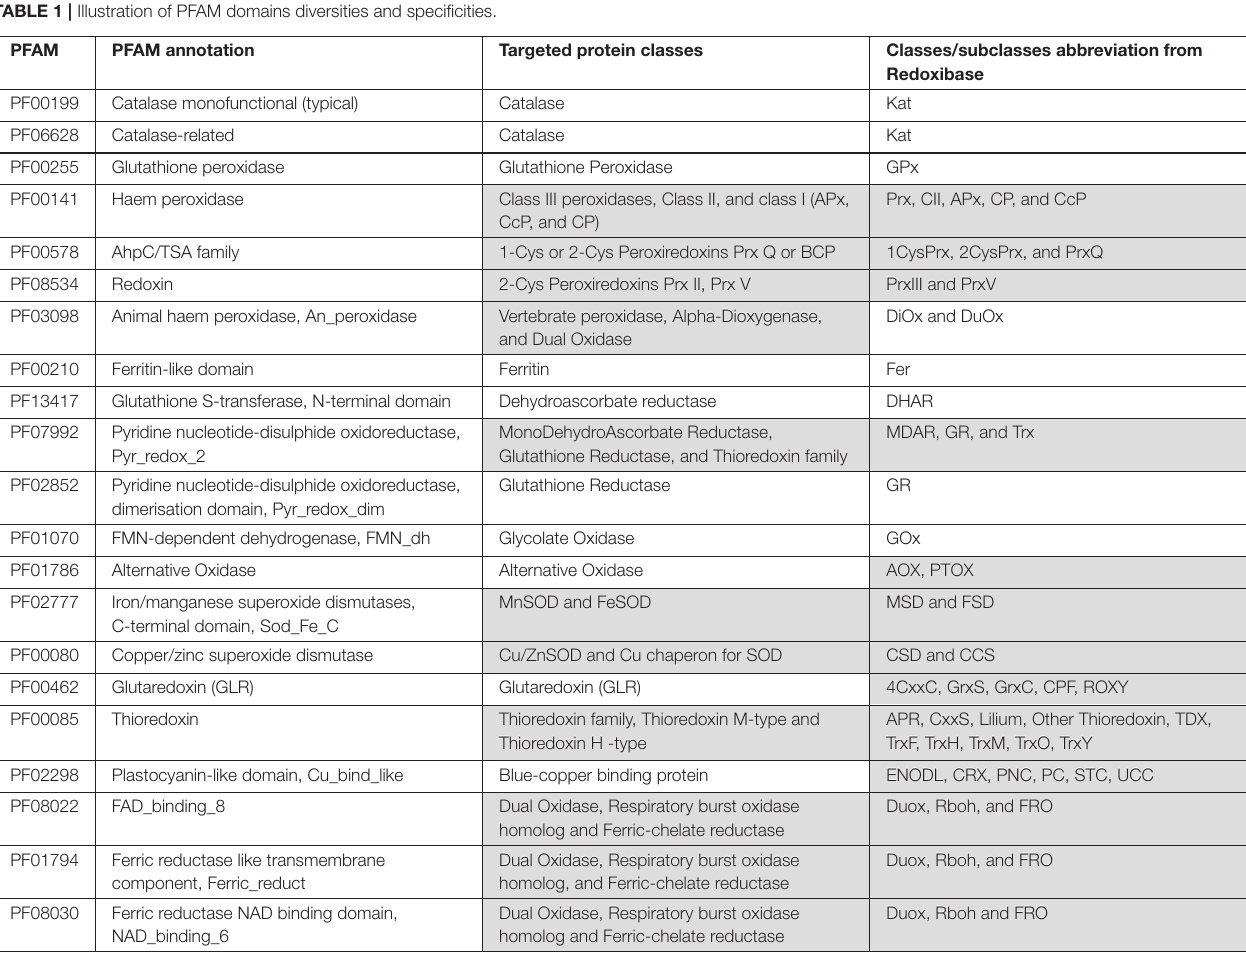
TABLE 1 | Illustration of PFAM domains diversities and